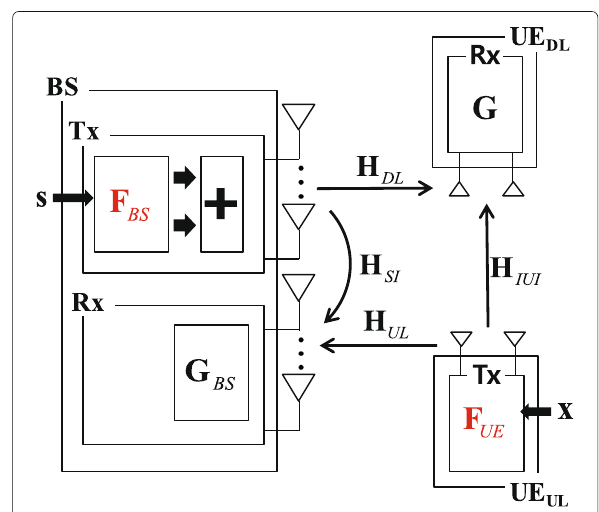
Fig. 1 A full-duplex two-user MIMO communication system. F BS and